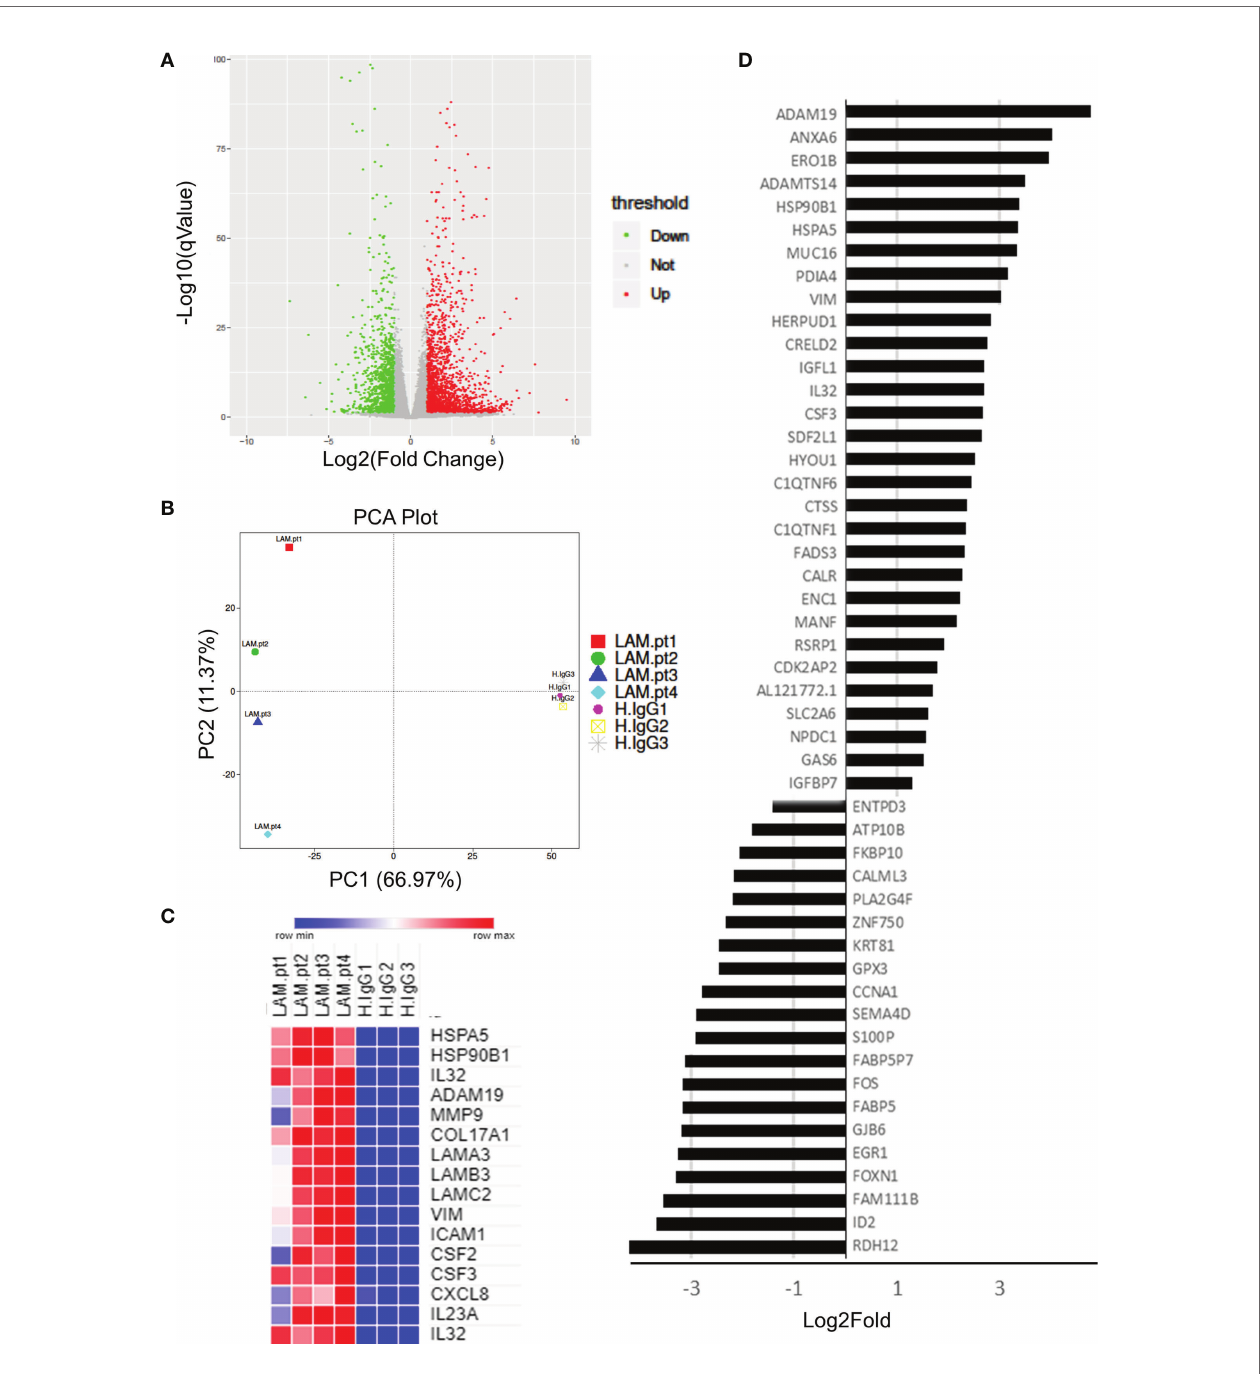
FIGURE 1 | Primary human keratinocytes were treated for 24 hours with 3.5 m g/ m L of IgG from patients with laminin-332 pemphigoid (n=4), or control IgG. 3 different cultures were used for control IgG treatments. RNA-seq was performed on keratinocytes, resulting in (A) 3,228 genes to be differentially expressed (2,050 up, 1,179 down) as shown on a Volcano plot. (B) Principal component analysis demonstrating discrete clusters between laminin-332 IgG autoantibody treated keratinocytes (Lam.pt) as compared to health control (H.IgG). (C) Expression heat map of selected cytokines, chemokines, heat shock proteins, proteases, and structural proteins. (D) Top 50 differentially expressed genes as sorted by false discovery rate, shown from most highly upregulated down